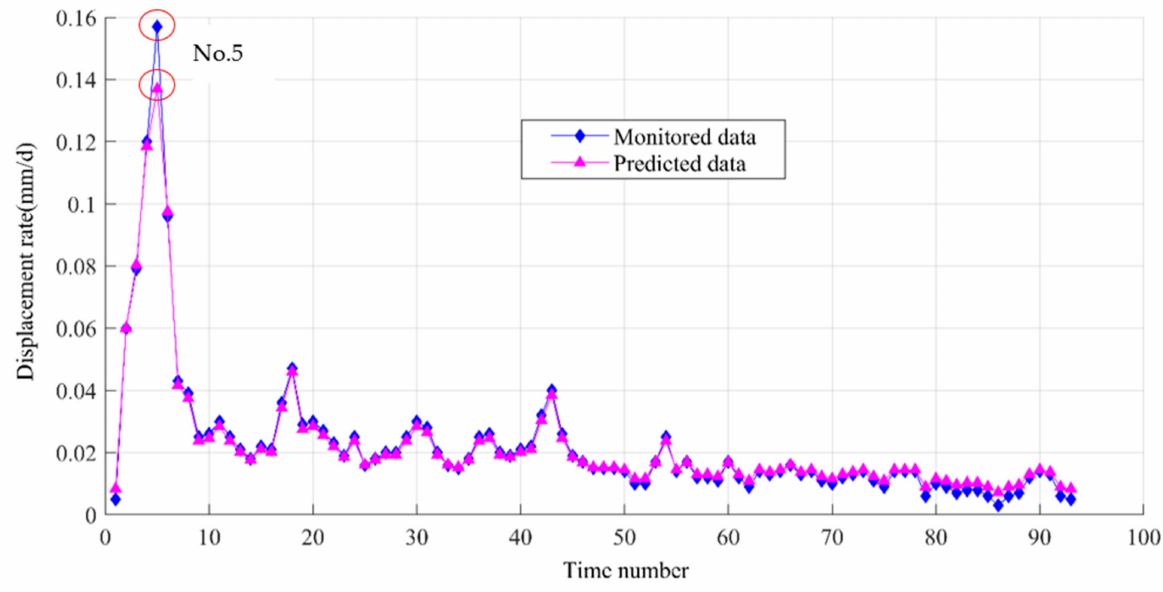
Figure 6. Monitored and predicted displacement rate of single-factor support vector regression machine (SVRM) model over